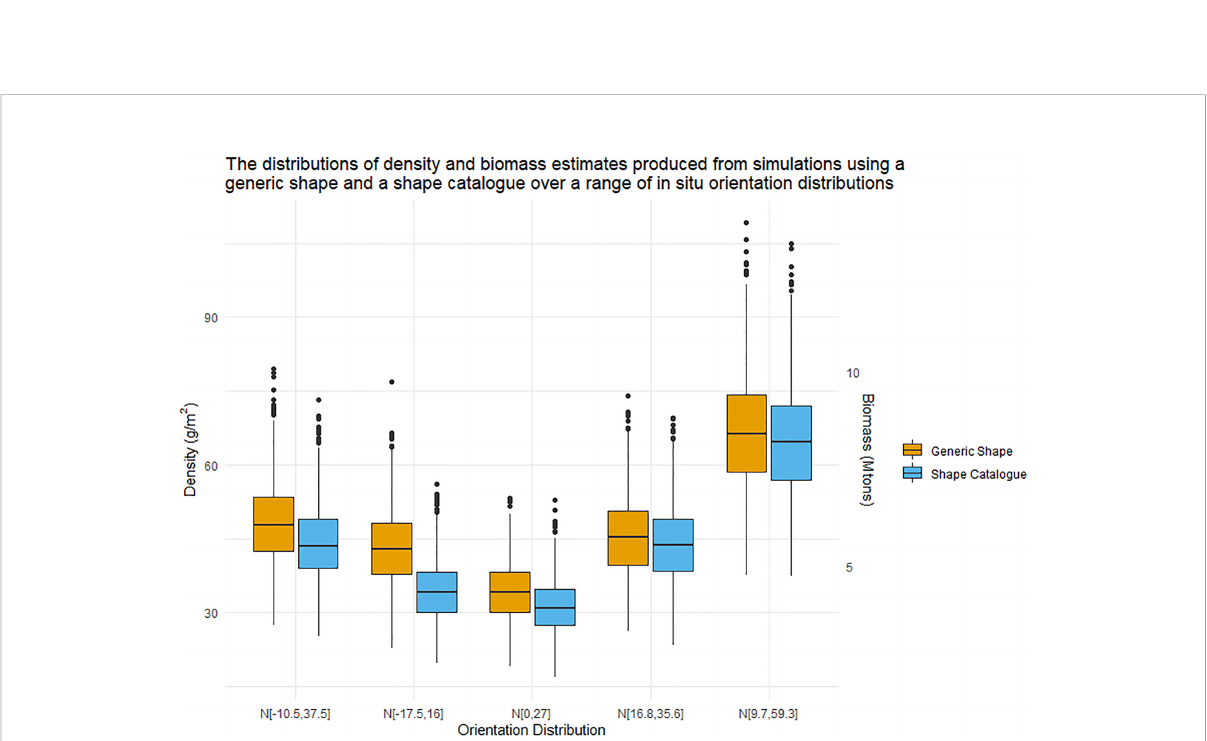
FIGURE 11 Boxplot distributions of krill density (left Y axis) and biomass (right Y axis) estimates produced by n sim simulations. The central line represents the median density or biomass estimate. These estimates were produced using both the generic shape (orange) and shape catalogue (blue) and fi ve in situ orientation